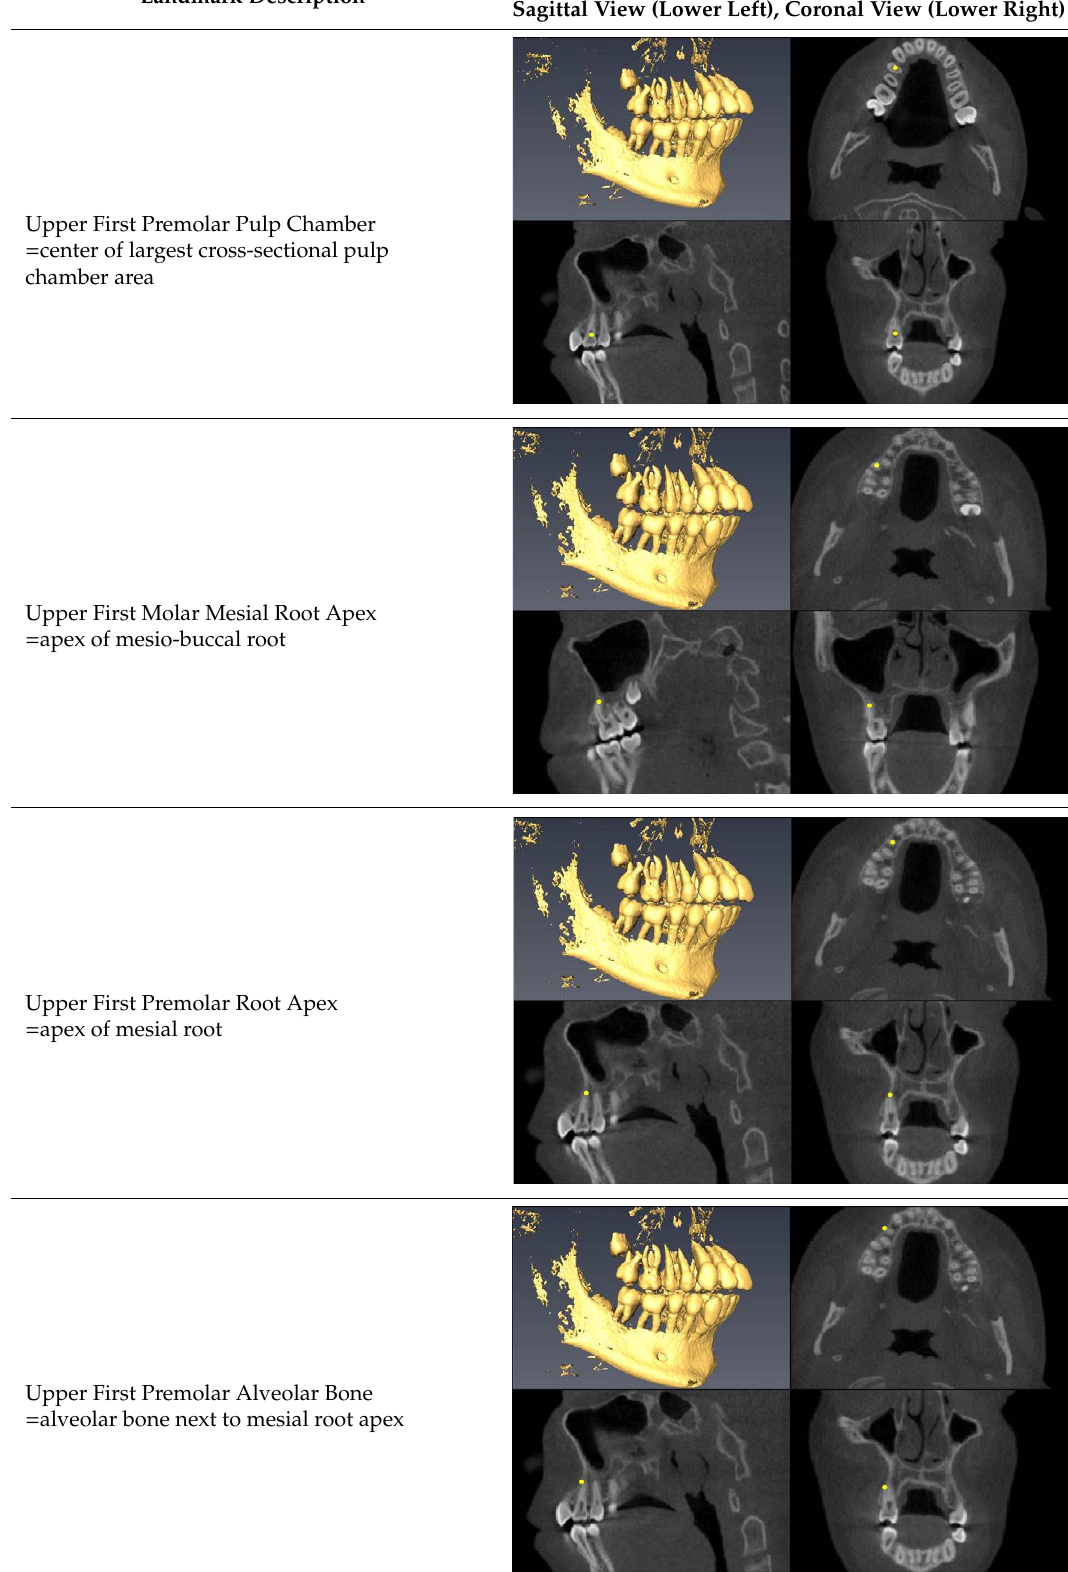
Upper First Premolar Pulp Chamber = center of largest cross-sectional